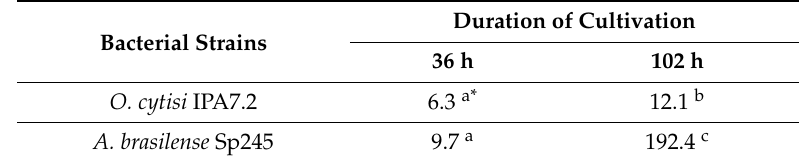
Table 2. Concentration of indolyl-3-acetic acid (ng ml -1 ) in the nutrient liquid synthetic malate-salt medium after cultivation of the